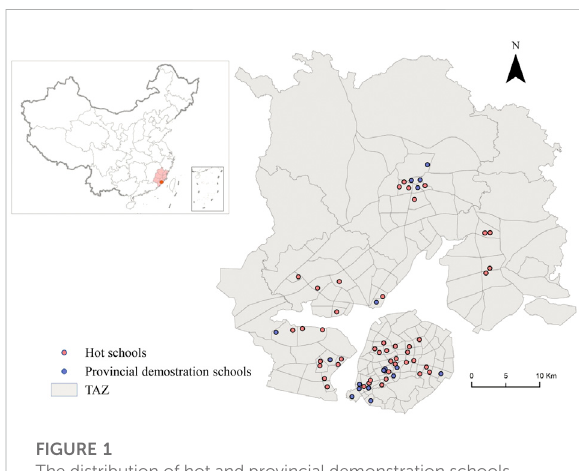
FIGURE 1 The distribution of hot and provincial demonstration schools in